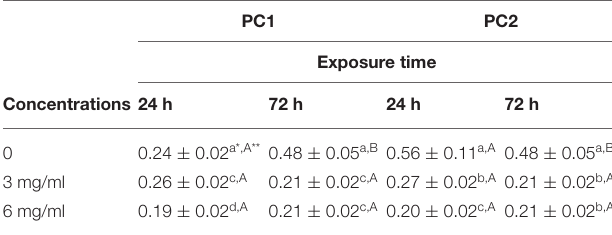
TABLE 1 | Mean cell viability for canine PC1 and PC2 cell lineages per concentration and exposure time to the latex of S. grantii by a tetrazolium reduction